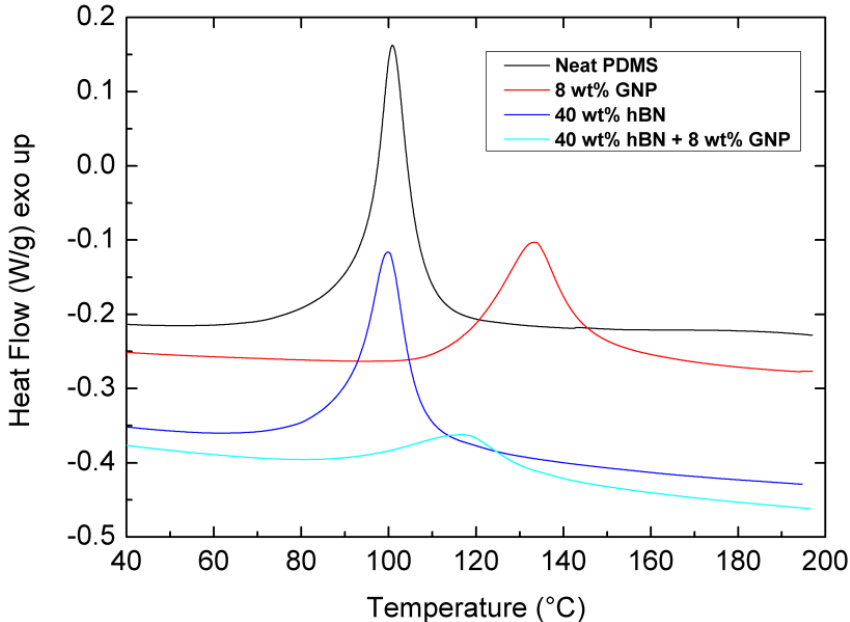
Figure 5. DSC scans with 10 °C/min heating rate for neat PDMS and nanocomposites containing different fillers and amounts of GNPs or/and hBN.